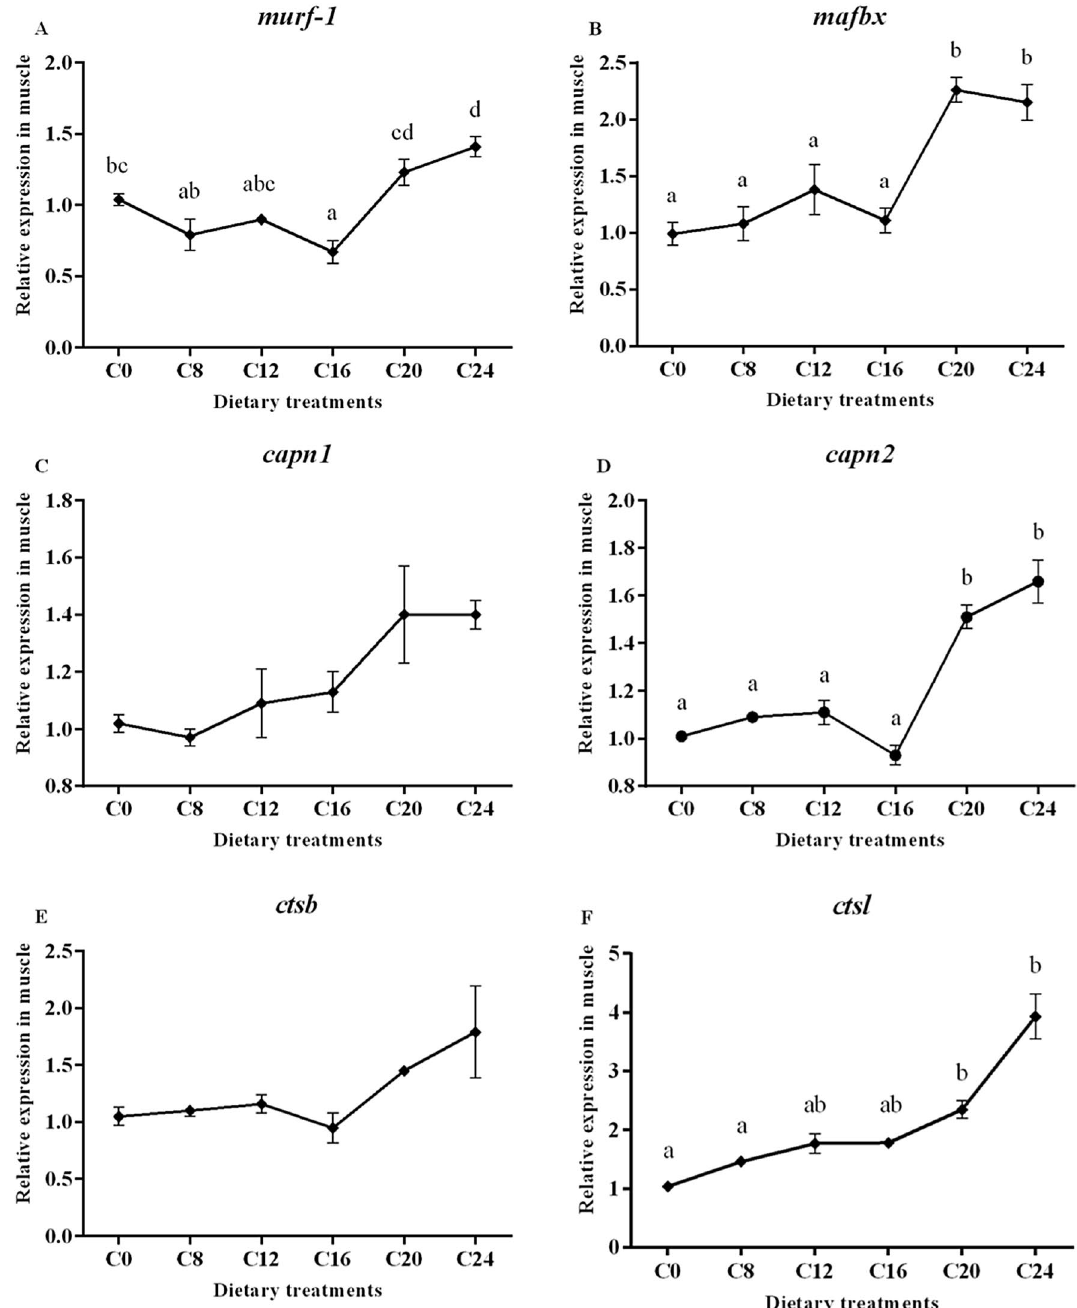
Figure 3. (1) Expression of genes about protein turnover ( murf-1 , mafbx , capn1 , capn2 , ctsb and ctsl ), mitochondria membrane infusion (mfn1 and mfn2), cristae organization (opa1), inflammation ( tnf-α and il-6 ), myogenic regulatory factors and mstn ( myf5 , myod , myog , mrf4 and mstn ), insulin-like factors receptors ( igf1r and igf2r ) and glycogen synthesis and glycogenolysis ( gysm and pygm ) in the skeletal muscle. Data are shown as mean ± SE. Values with different letters means significant differences (p < 0.05, Tukey’s